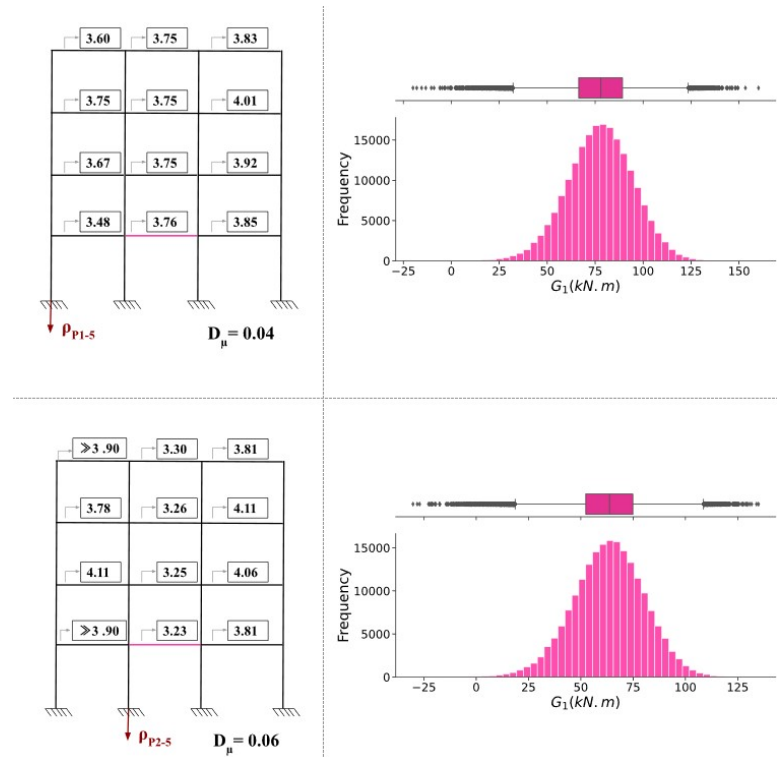
Figure 6. Reliability